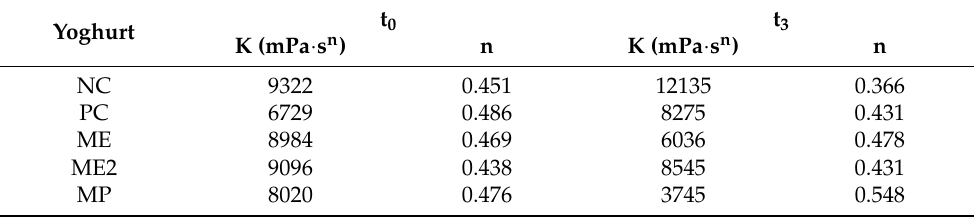
Table 4. Consistency index (K) and flow consistency index (n) parameters obtained for